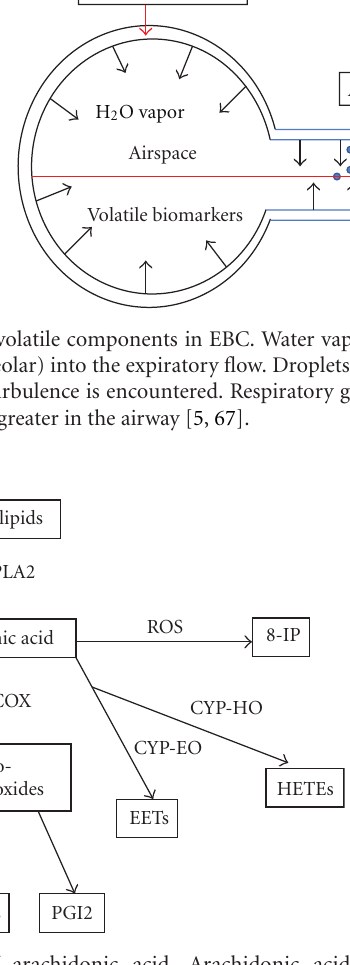
Figure 2: Metabolism of arachidonic acid. Arachidonic acid is released from phospholipids by the action of phospholipase A2 (PLA2). Arachidonic acid is metabolized by cyclooxygenases (COXs), lipoxygenases (LOXs), and cytochrome P450 (CYP). COXs metabolize arachidonic acid to prostaglandins (PGs), prostacyclin (PGI2), and thromboxanes (TXs). Leukotrienes (LTs) are the final arachidonic acid metabolites in the 5-lipoxygenase- (5-LO-) medi- ated pathway. CYP epoxygenases (CYP-EO) metabolize arachidonic acid to epoxyeicosatrienoic acid (EETs), and CYP hydroxylases (CYP-HO) metabolize arachidonic acid to hydroxyeicosatetraenoic acids (HETEs). 8-Isoprostane (8-IP) can be generated in vivo by the free radical-catalyzed peroxidation of arachidonic